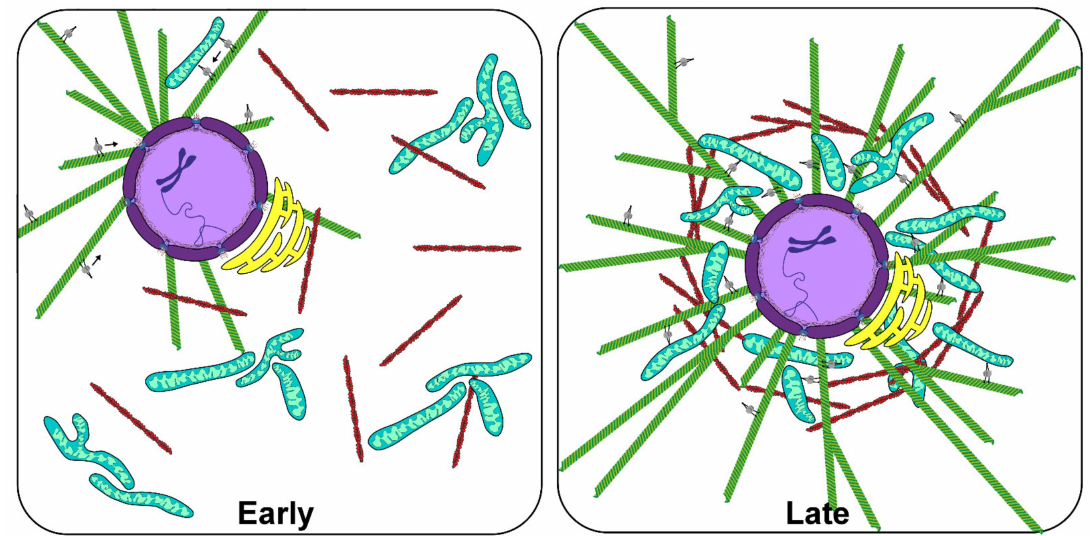
Figure 2. Microtubule-dependent self-organization of Xenopus laevis egg extract. Representative schematics of early and late stage organization of X. laevis egg extract during interphase. In the early stage (left panel), a microtubule aster (green) associated with the nucleus (purple) begins to expand and makes contact with dispersed elements of the cytosol including the ER (yellow), mitochondria (blue), and actin cytoskeleton (red). After reaching steady state (right panel) the microtubule cytoskeleton has centered itself in the region of interest, together with it the associated nucleus and ER. Clustering of mitochondria towards the “cell” center through the activities of minus-end directed motors such as cytoplasmic dynein (gray) occurs concurrently with microtubule aster centering and continues until most membranous cargos are cleared from more distal